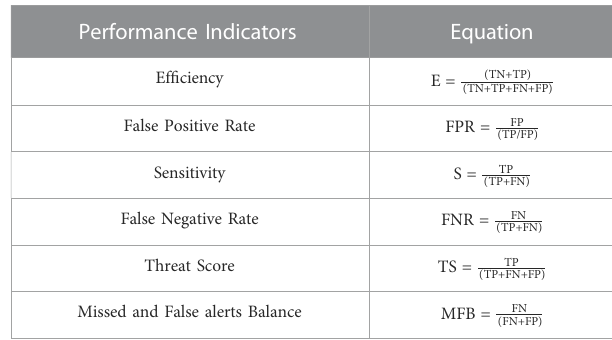
TABLE 3 List of performance indicators used in the analysis and their